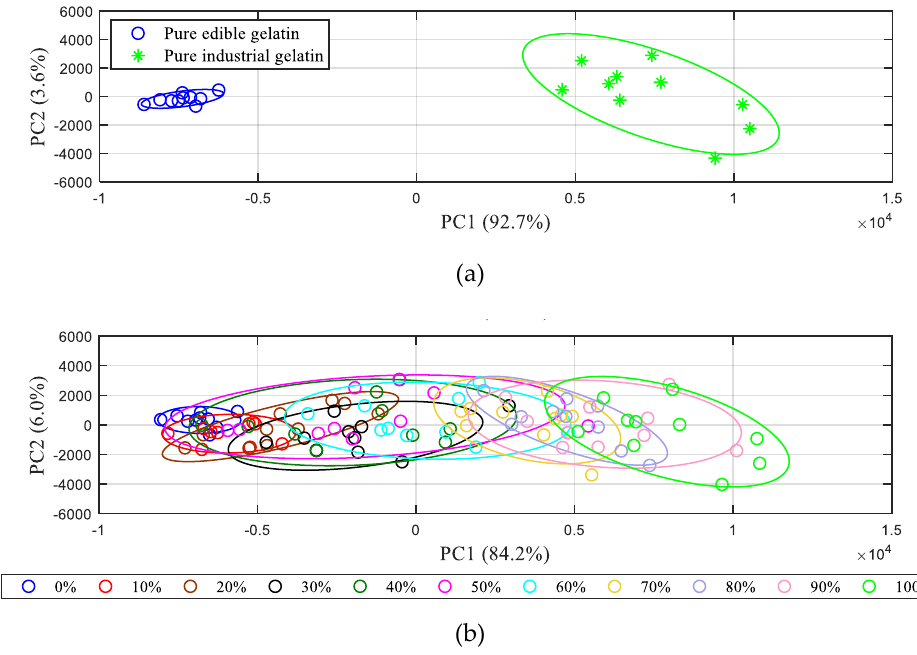
Figure 4. Scatter plot of the first two principal components of ( a ) pure edible gelatin and industrial gelatin and ( b ) all 11 varieties of adulterated